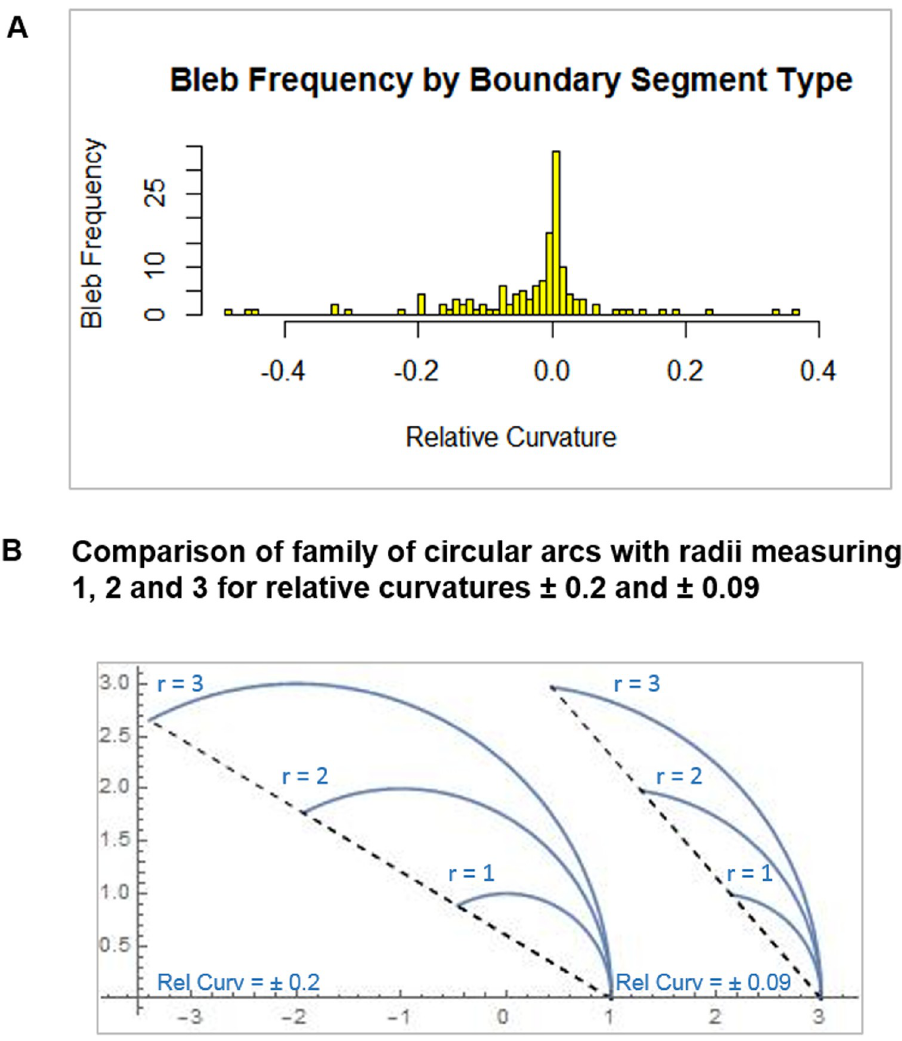
Fig 9. Relative curvature and blebbing. (A) Histogram showing the distribution of blebbing sites by local relative curvature. The mean relative curvature for concave blebbing sites is 0.9 with standard deviation 0.11. (B) Examples of relative curvature. The first is 0.09 the mean relative curvature identified in the histogram. The second is 0.2 = 0.09 + 0.11, the mean plus one standard deviation.